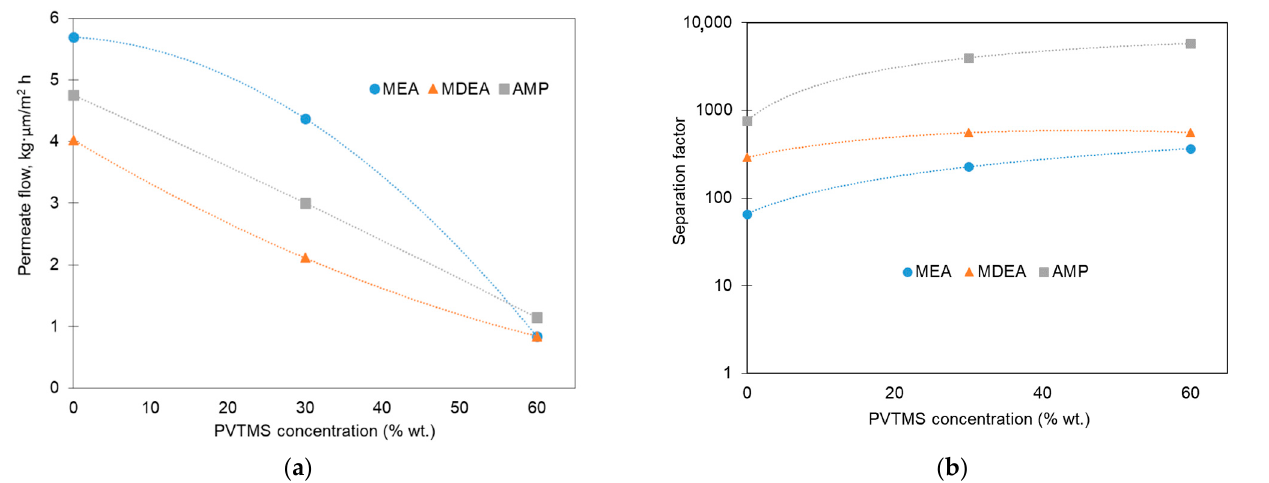
Figure 10. TPV results for model solvents (aqueous solutions of MEA (30% wt.), MDEA (40% wt.), and AMP (30% wt.) in distilled water) at T = 60 °C: ( a ) permeate (solvent vapors) flows, normalized and AMP (30% wt.) in distilled water) at T = 60 ◦ C: ( a ) permeate (solvent vapors) flows, normalized by the membrane thickness, and ( b ) separation factors. by the membrane thickness, and ( b ) separation